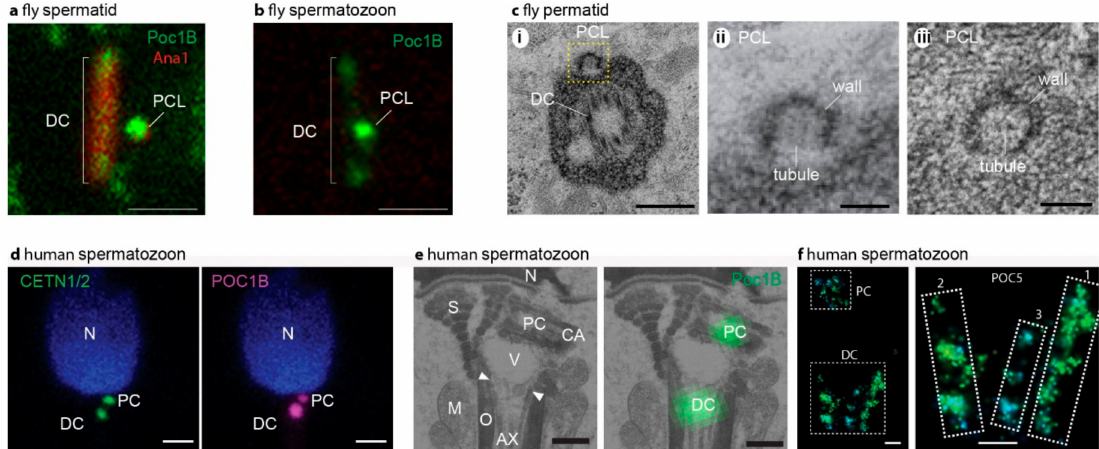
Figure 3. Sperm centrioles in flies ( a – c ) and mammals ( d – f ). ( a ) Fluorescent microscope picture of fly spermatid with DC and PCL labeled by the centriolar protein Poc1B and Ana1. ( b ) Fluorescent microscope picture of fly spermatozoon with Poc1B faintly labeling the DC and intensely labeling the PCL. In ( a , b ) the scale bar is 1 µ m, Poc1B is genetically tagged by GFP, and Ana1 is genetically tagged by tdTomato. ( c ) Electron microscope picture of fly spermatozoon centrioles. ( i ) A section in a plane that has a cross-section of the DC and longitudinal section of the PCL (yellow box). ( ii ) Zoom in the PCL boxed in ( i ). ( iii ) A cross-section of the PCL depicting the wall and central tubule. In ( c ), the scale bar is 0.1 µ m. ( d ) Fluorescent microscope picture of a human spermatozoon with CENTE1/2 or POC1B labeling the DC and PCL. The scale bar is 1 µ m. CENTE1/2 and Poc1B are labeled by specific antibodies. ( e ) Correlative light and electron microscopy picture of human spermatozoon centrioles. On the left, electron microscopy section depicting POC1B labeling of the PC that is found near the nucleus, and the DC that is attached to the axoneme. Ax, axoneme; M, mitochondria; mp, tail midpiece; N, nucleus; ne, neck; O, outer dance fibers; S, striated columns; V; vault; CA; centriole adjunct. ( f ) Stochastic Optical Reconstruction Microscopy (STORM) super-resolution fluorescent microscopy picture of bovine spermatozoon centrioles. On the left, a picture depicting POC5 labeling of the PC and the DC. On the right, zooming in on the DC identifies two major rods (marked as “1” and “2”) and one minor rod (marked as “3”) labeled by POC5. In ( f ), the scale bar is 0.1 µ m. Panels ( a – c ) are from Khire 2016 [15]. Panels ( d – f ) are from Fishman